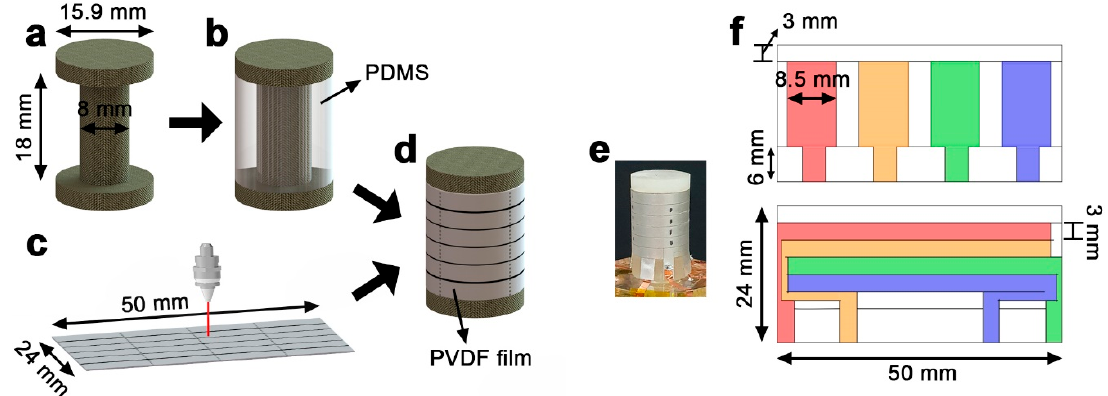
Figure 8. Schematic diagram showing the fabrication process of the cylindrical piezoelectric force